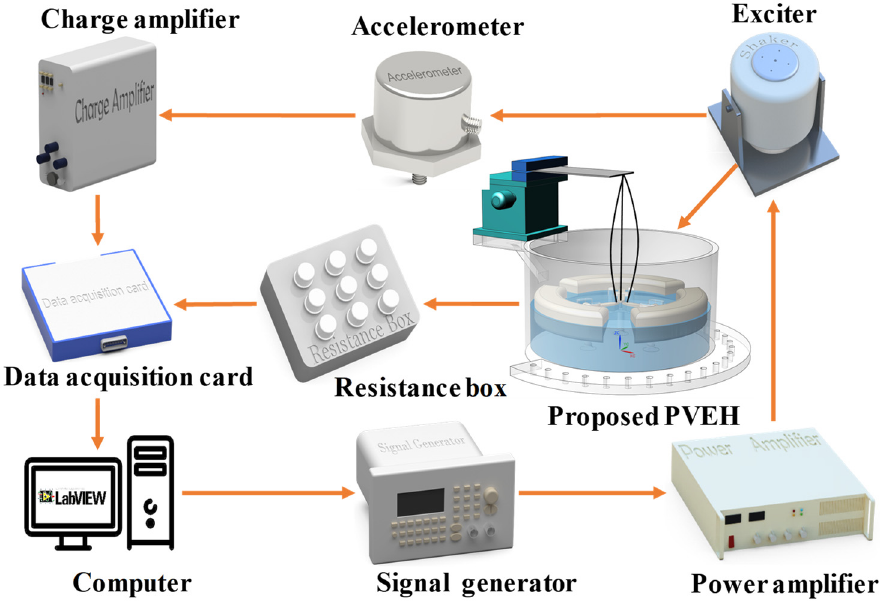
Figure 6. Experimental setup for the proposed PVEHs.